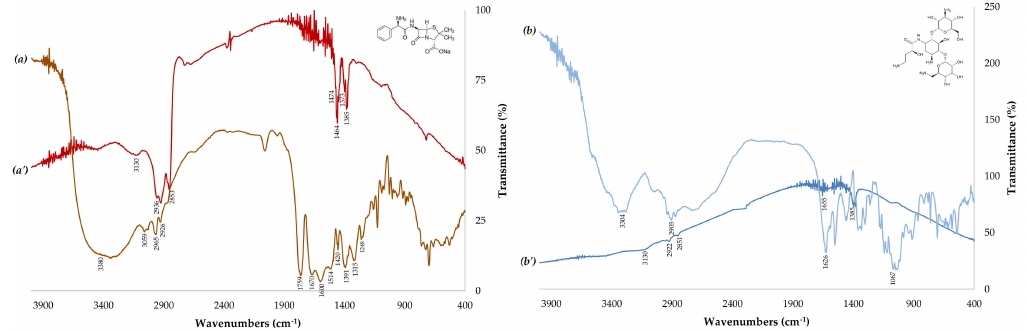
Figure 3. FTIR spectra of the antibiotics and their combinations with silver nanoparticles. ( a ) AMP: Ampicillin; ( a’ ) AgNPs + AMP; ( b ) AMK: Amikacin; ( b’ ) AgNPs + AMK. Insets: AMP and AMK